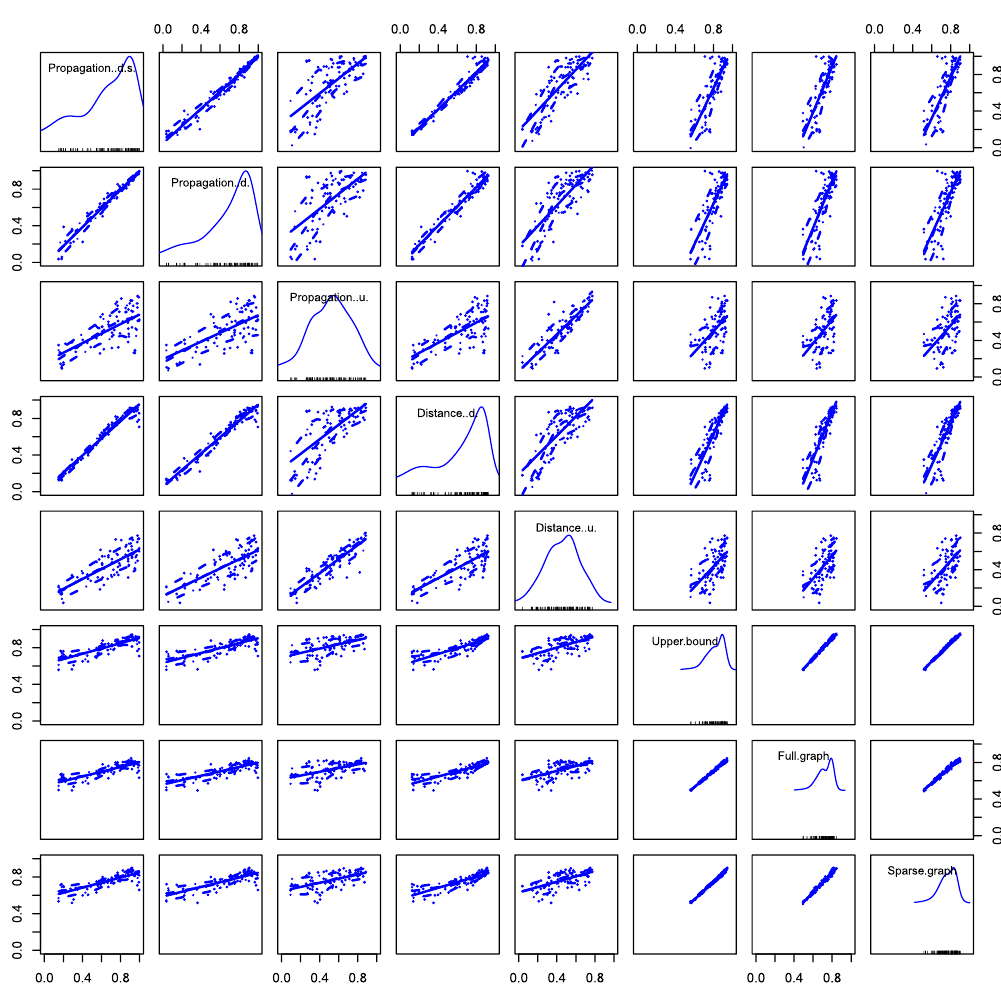
Figure 4. Pairwise accuracy between DYNAMO and enhancement models on the selected 87